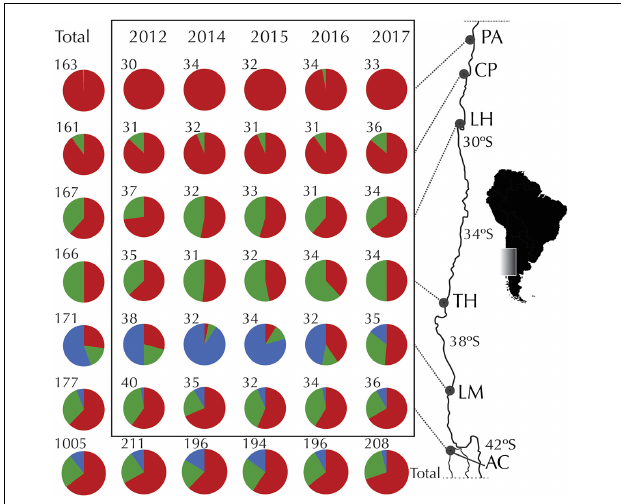
FIGURE 1 | Temporal variation of COI haplogroups of Pyura chilensis. Geographic distribution and relative frequency of COI haplogroups for temporal samples (years 2012, 2014, 2015, 2016, and 2017). Pie charts represent the total number of sequences analyzed, colors represent COI haplogroups (red: Hg1, green: Hg2, blue: Hg3), and numbers by the pies indicate number of individuals analyzed per site per year.